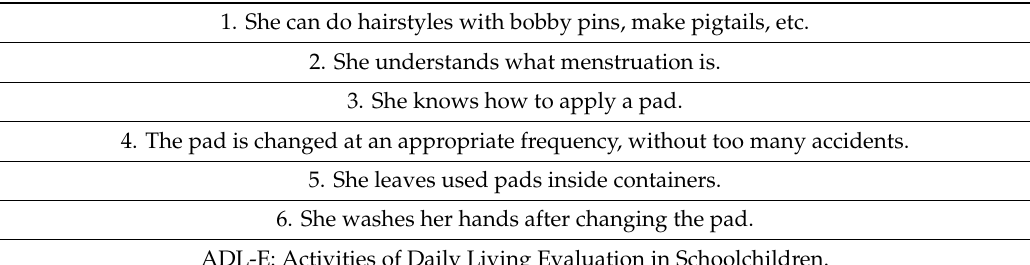
Table 3. Qualitative ADL-E items for girls on the Personal Hygiene scale.